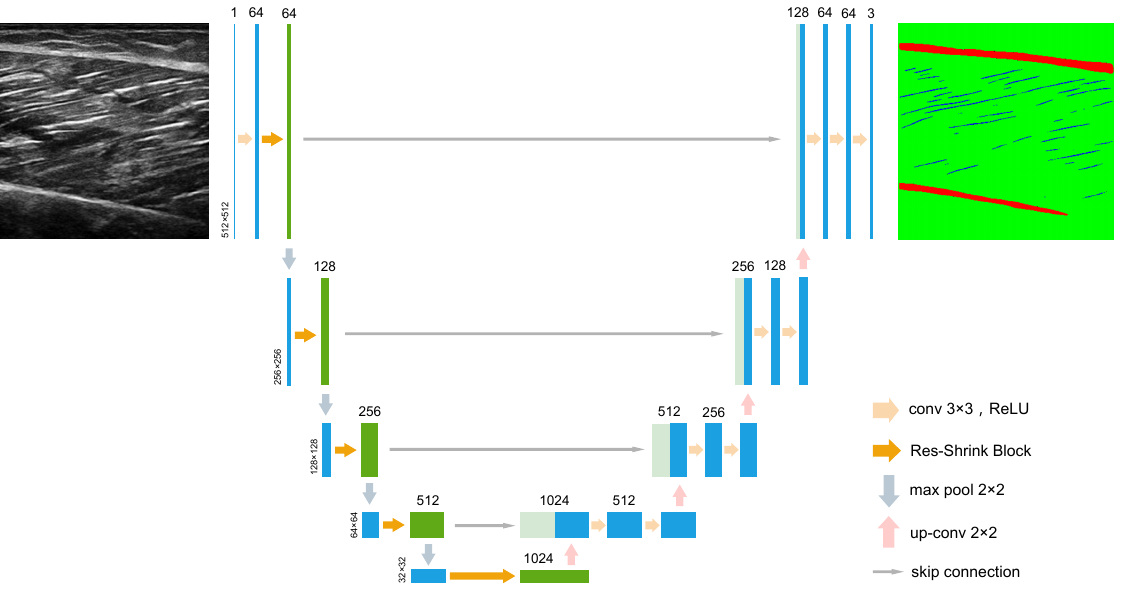
Figure 2. The network architecture of the RS-Unet. The Res-Shink block represents a residual shrinkage block in the